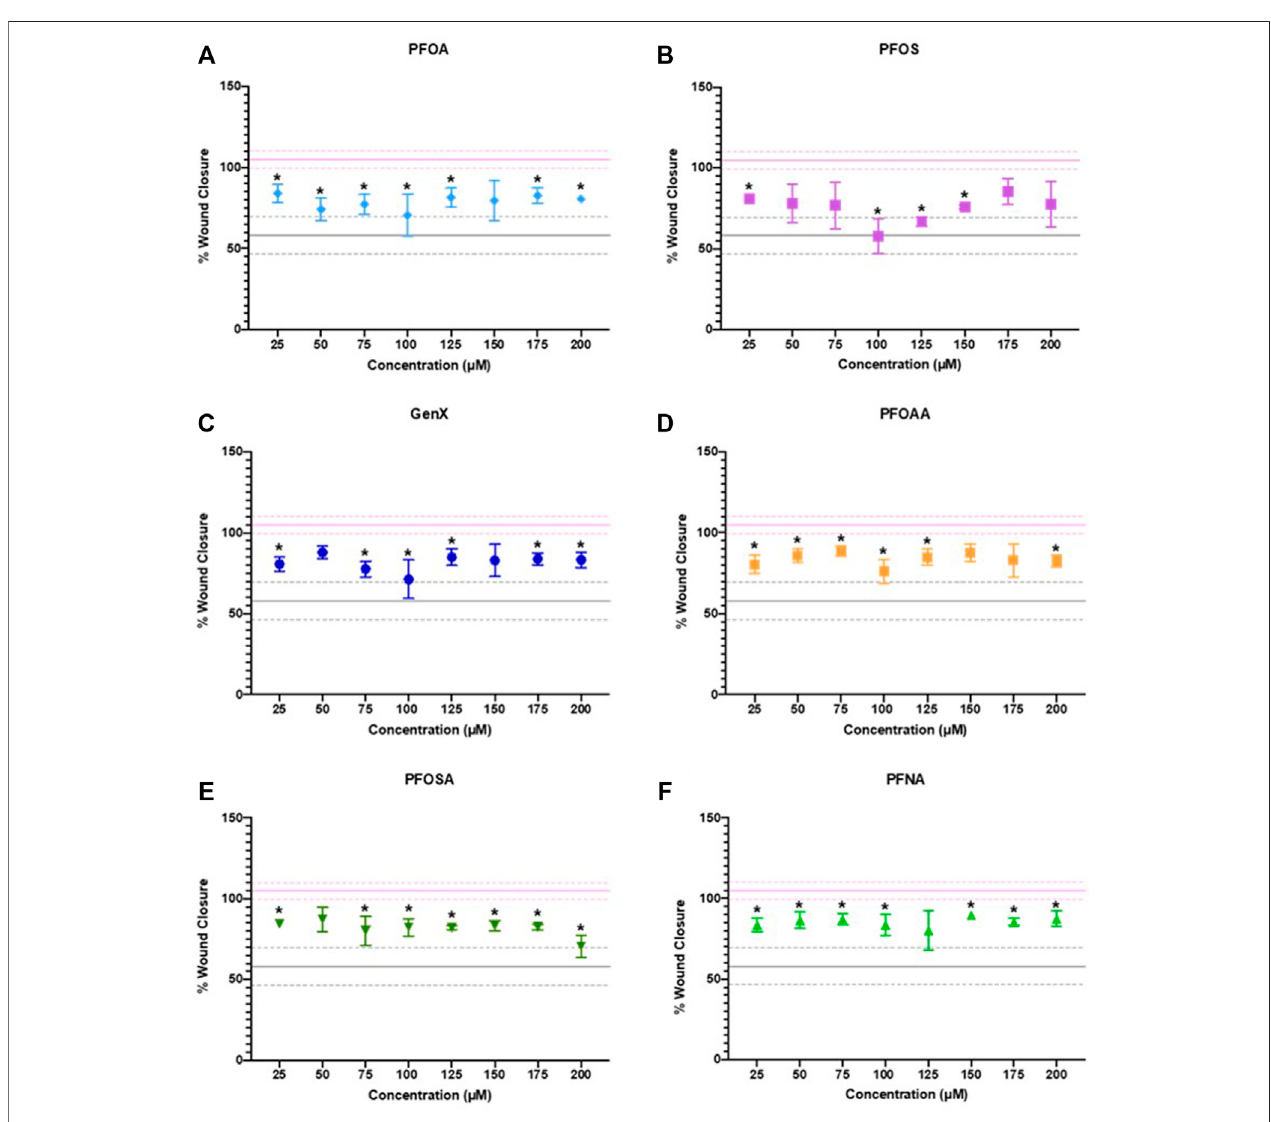
FIGURE5| JEG-3cellmigrationafter24hofexposureto (A) PFOA, (B) PFOS, (C) GenX, (D) PFOAA, (E) PFOSA,and (F) PFNA,assessedusingascratchwound assay.Foreachchemical,migrationisexpressedas%woundclosure,whichmeasurestheextenttowhichJEG-3cellsmigratedacrossthescratchwoundbetweenthe initialscratchwasmadeand24hpost-scratch(mean±SD).Theupperpinksolidline fl ankedbydottedlinesrepresentsthemean±SDforvehiclecontrol(2%methanol). Thelowergraysolidline fl ankedbydottedlinesrepresentsthemean±SDvaluesforthepositivecontrol(25 µMcadmiumchloride).N=2 − 4biologicalreplicatesper chemical and dose. Signi fi cance was determined using multiple unpaired t-tests comparing experimental conditions to the vehicle control followed by post hoc correction using the Bonferroni-Dunn method, * p < 0.05. Representative images are shown in Supplementary Figure S7 .